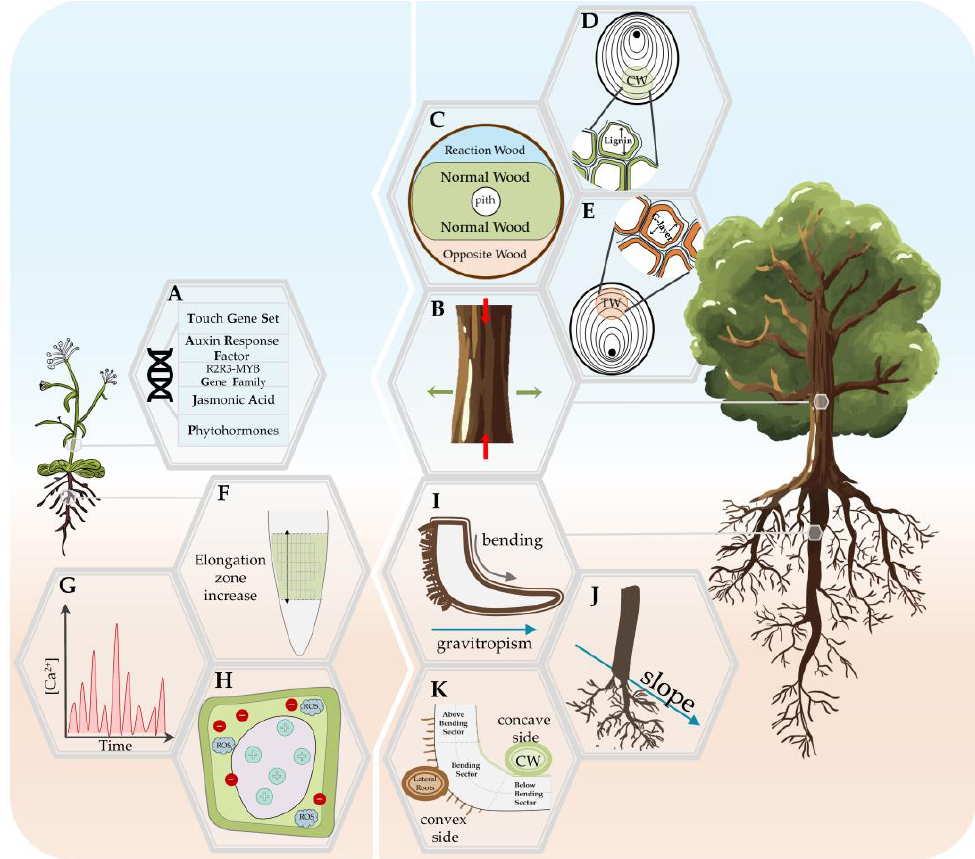
Figure 2. Summary of the mechanical stress response in annual ( Arabidopsis ; left panel) and woody plants (right panel). ( A ) Mechanical stress-related molecular responses in Arabidopsis stem. ( B ) Zones of differentiated growth in woody plant stems subjected to mechanical stress (reaction wood, RW; normal wood, NW; opposite wood, OW). ( C ) Location and characteristics of the tension wood (TW) formation, i.e., the RW in the stem of the Angiosperm specie. ( D ) Location and